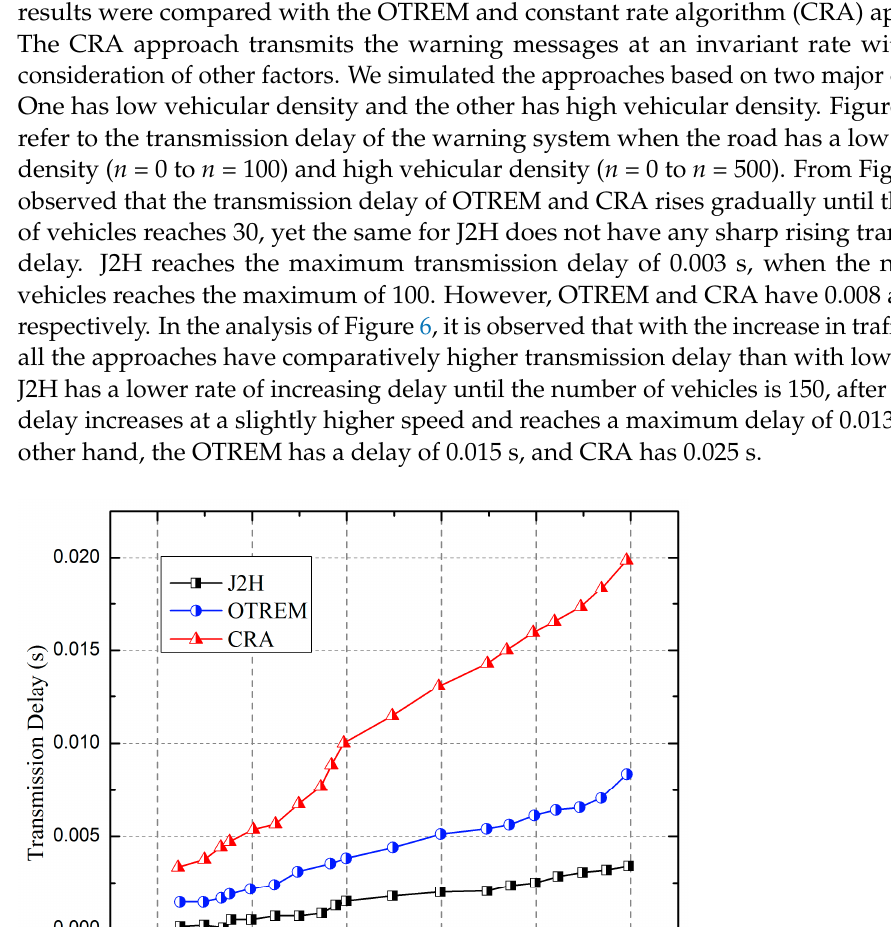
Figure 6. Analysis of transmission delay in transmitting alert messages with high density of vehi- cles. In order to estimate the constant rate of transmission delay, we simulated the ap- proaches five times, each with a low density and high density of vehicles, and the results are plotted in Figures 7 and 8. On the analysis of maximum transmission delay, it is ob- served that both the J2H and OTREM approaches have a similar rate of increase in the